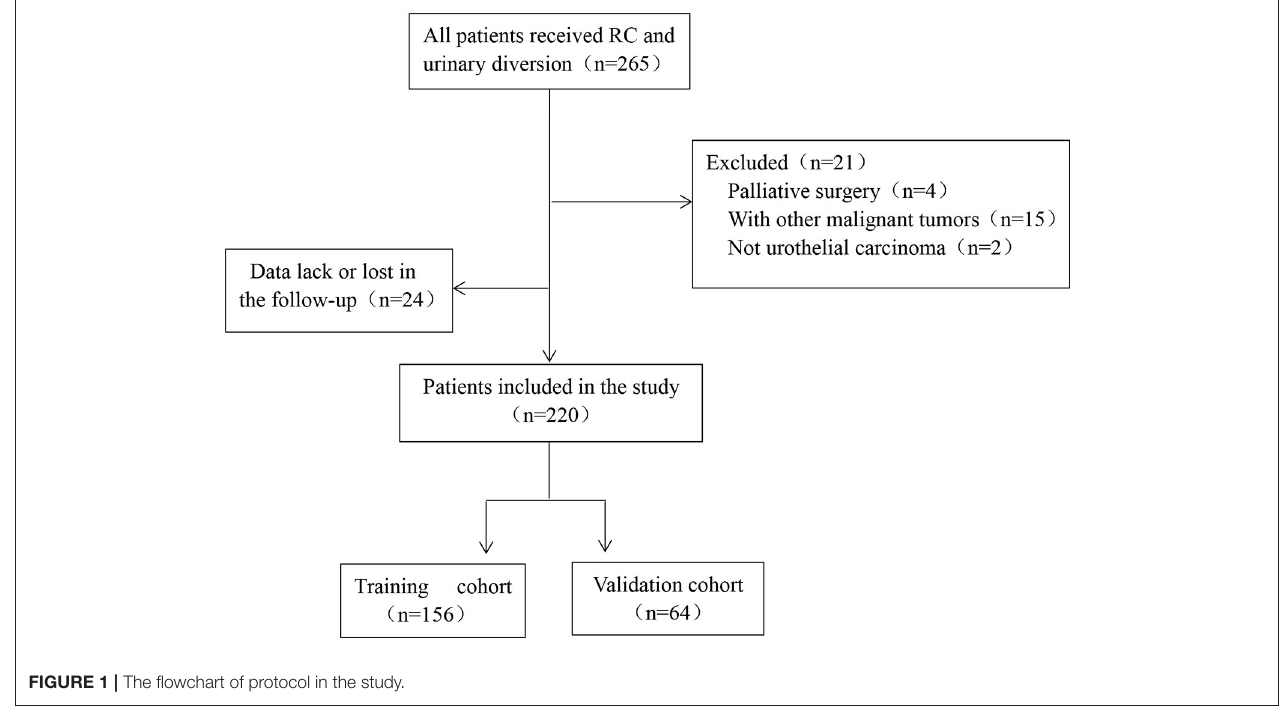
FIGURE 1 | The flowchart of protocol in the study.